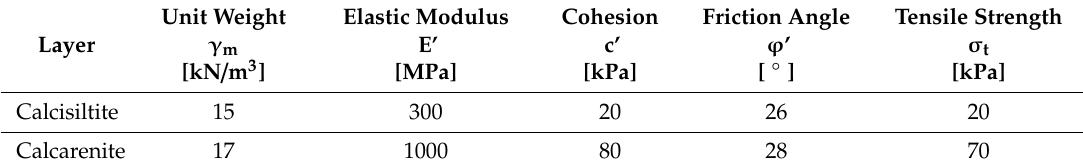
Table 3. Values of rock material parameters adopted in the numerical